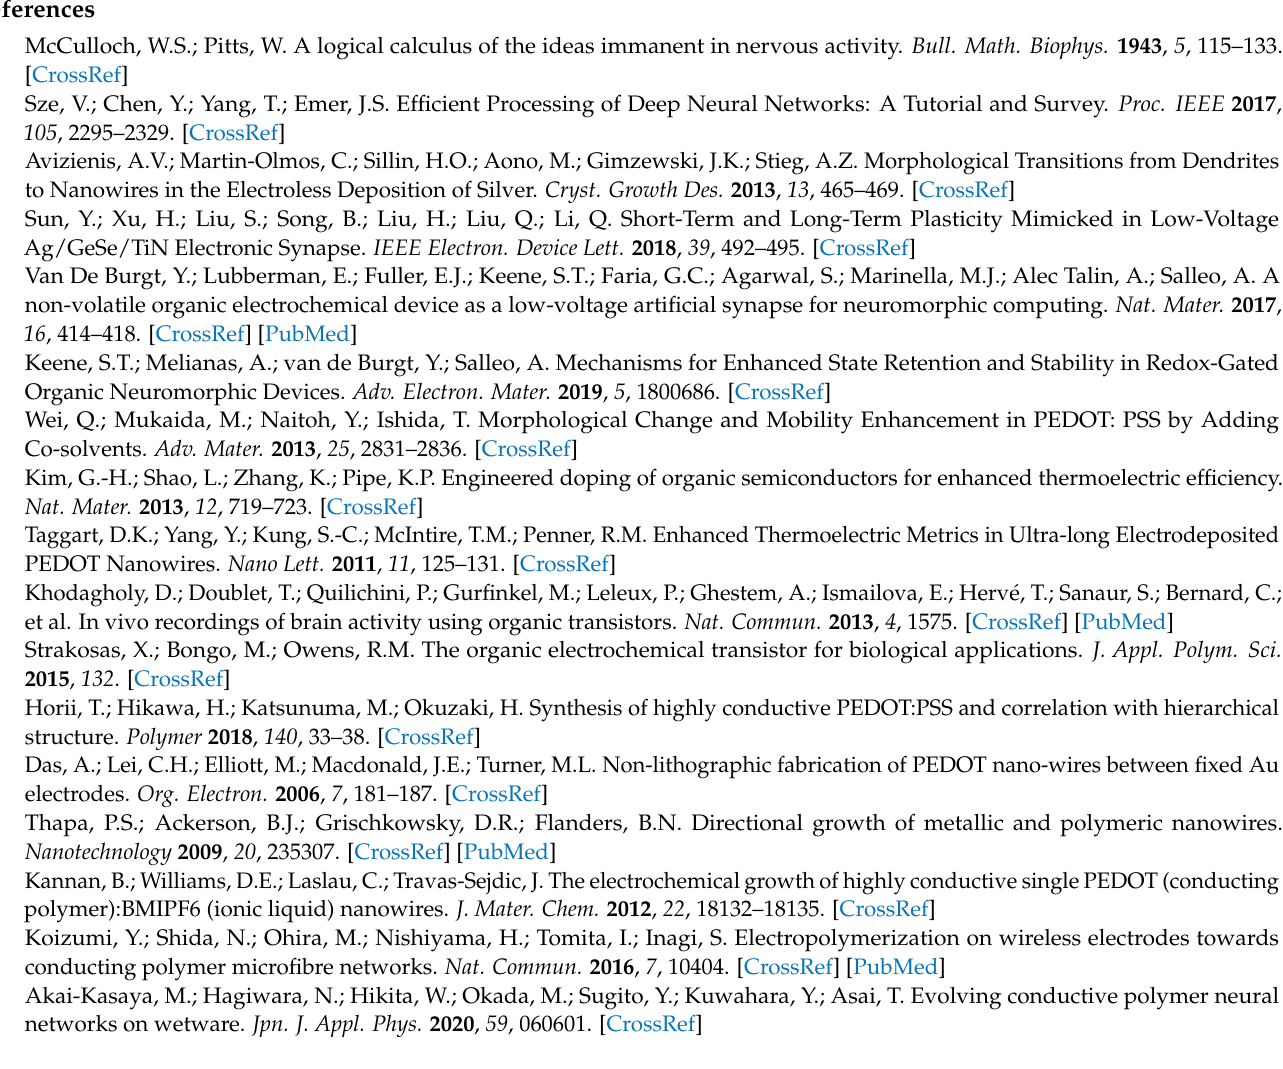
Figure S2: Voltage pulse interval dependence of conductive polymer wire diameter distribution change, Figure S3: The transition from LTP to